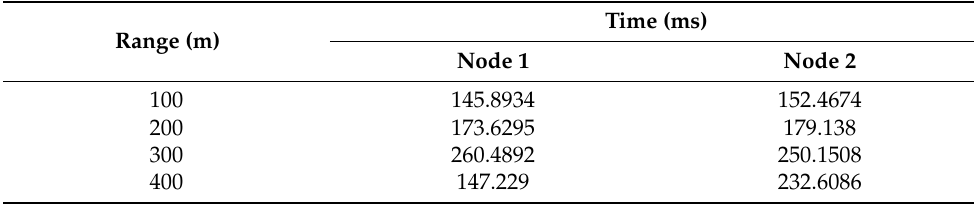
Table 1. The result with default parameters.